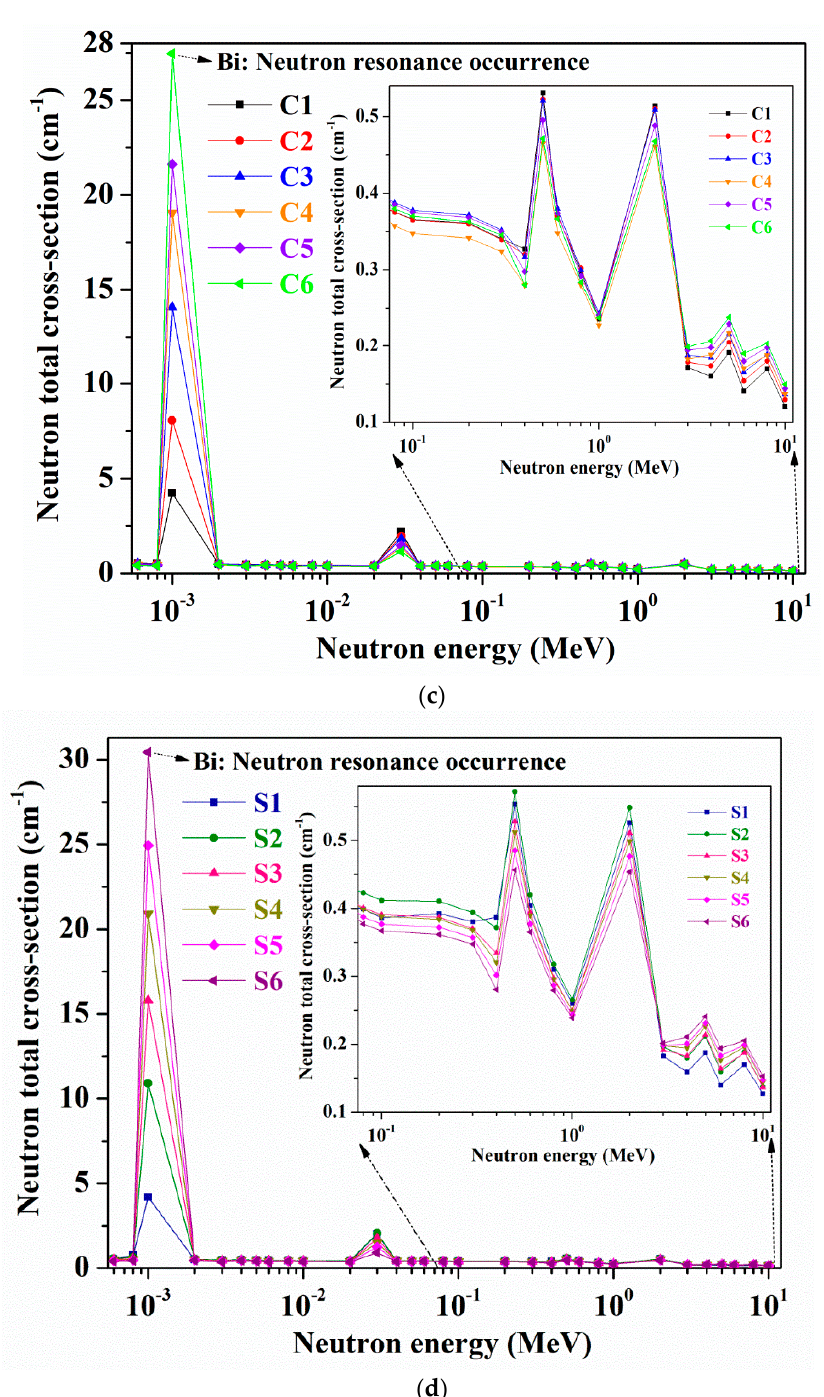
Figure 7. Variations of neutron total cross-section ( σ T ) within the neutron energy range of ( a , b ) (1 × 10 − 8 –5 × 10 − 4 MeV), and ( c , d ) (6 × 10 − 4 –10 MeV) (insets, within the ranges of 0.075–10 MeV energies) for all C1–C6 and S1–S6